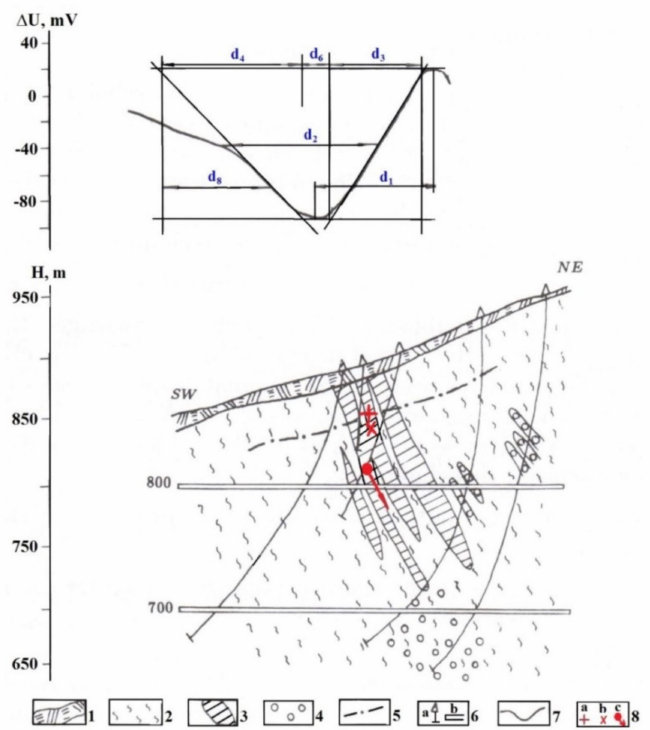
Figure 10. Interpretation by the developed techniques of SP anomaly in the area of the Potentsialnoe deposit (Rudny Altai, Russia) (initial data from [95]). (1) Soil-vegetative layer; (2) alternation of lavas and tuffs of acid composition and chlorite-sericitic schists; (3) sulfide ores; (4) sulfide impregnation, pyritization; (5) level of ground waters; (6) drilling wells (a) and adits (b); (7) SP plot; (8) interpretation results: (a) center of the upper edge of the thin bed, (b) mid-point of the inclined thick bed’s upper edge, (c) center of a horizontal circular cylinder (arrow indicates the direction of the polarization vector obtained by